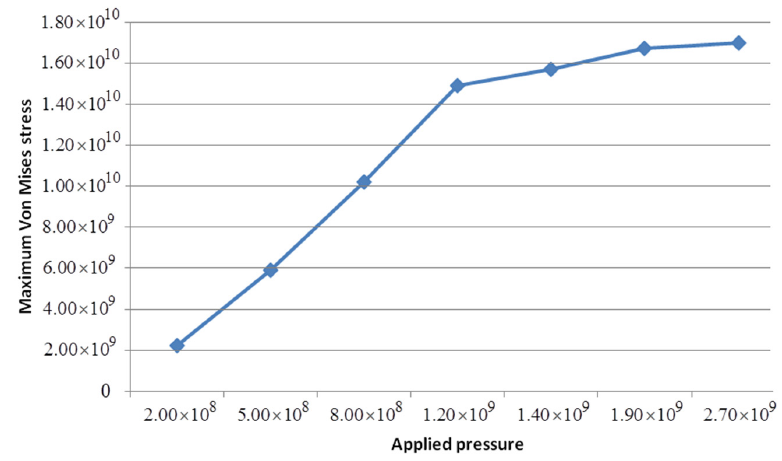
Figure 6. Relationship between the maximum Von Mises stress and imprinting pressure (units of Pa).